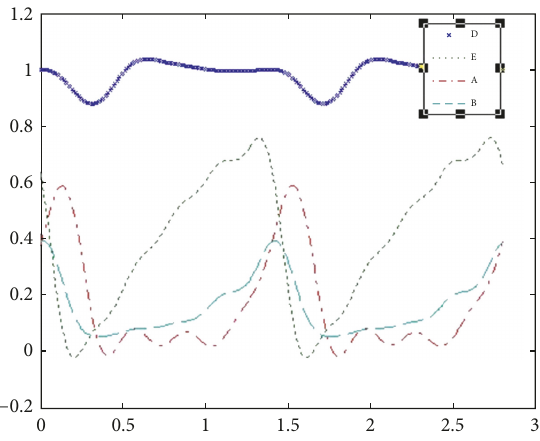
Figure 4: Complete cell division system